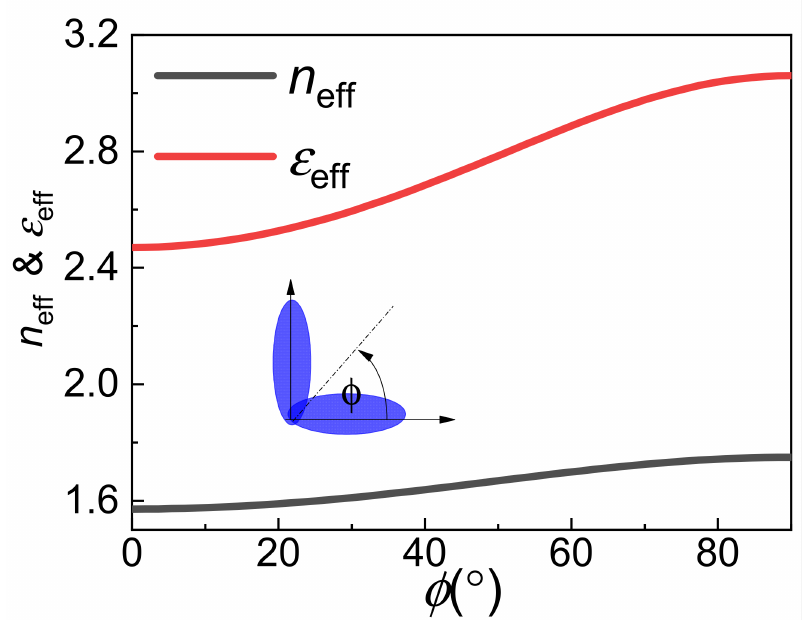
Figure 1. Effective refractive index ( n eff ) and permittivity ( ε eff ) varied with rotation angle φ of liquid